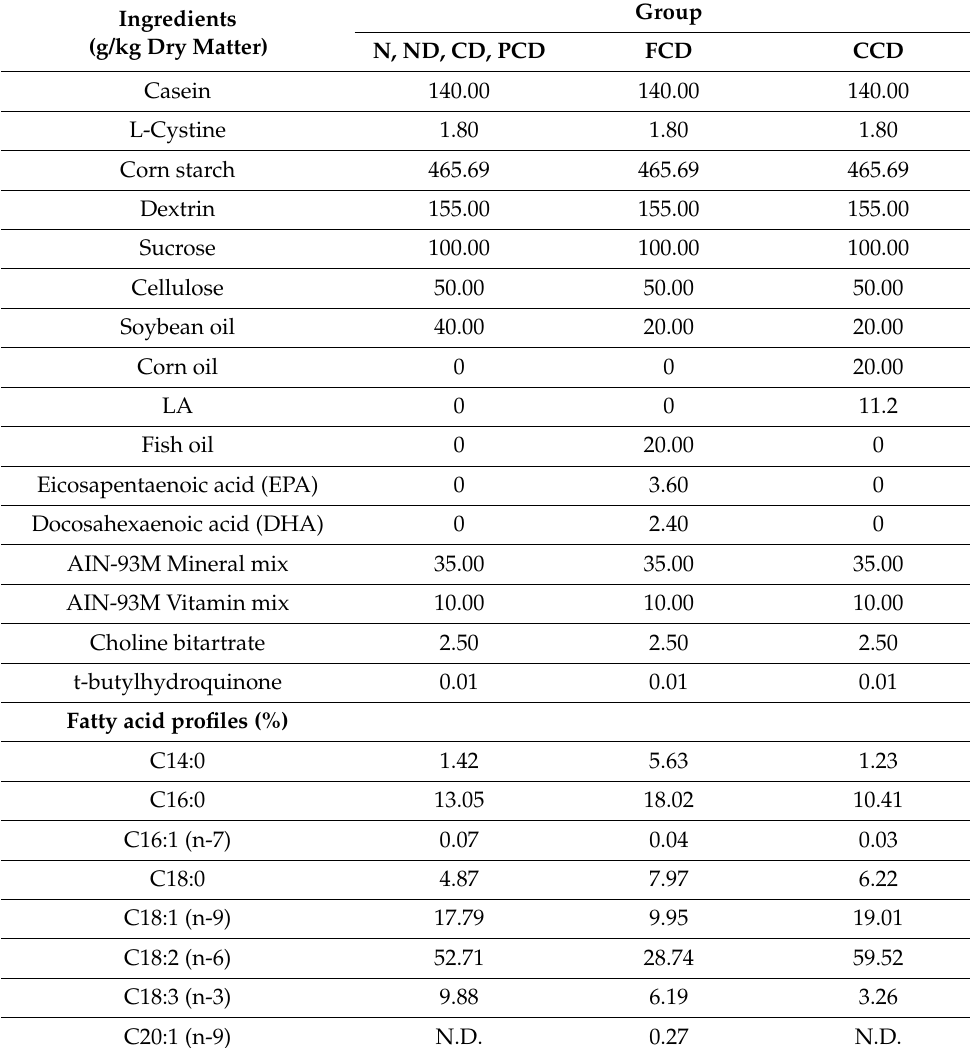
Table 1. The composition of diet in different